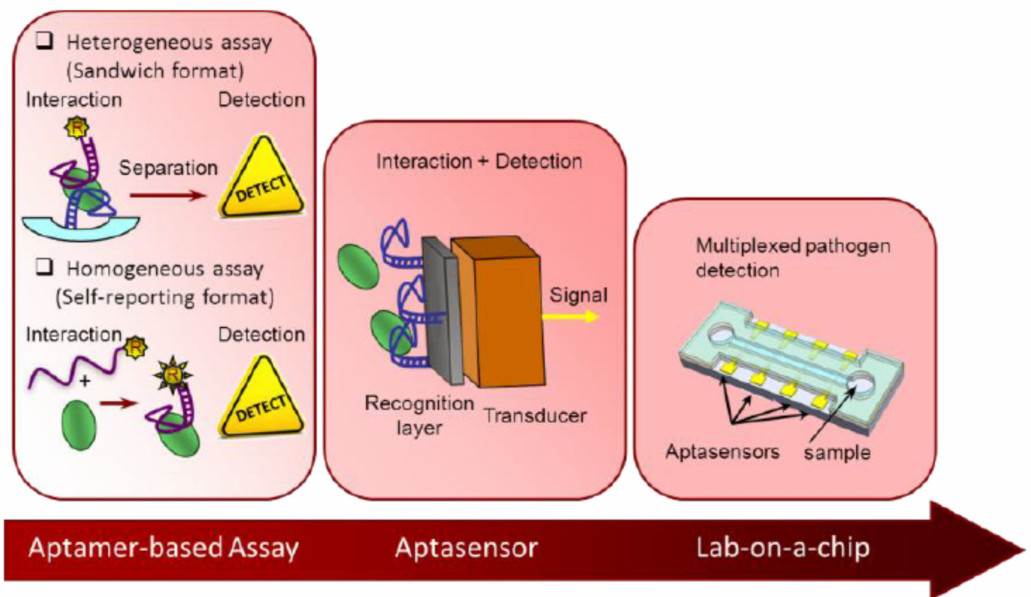
Figure 1. Aptamer-Based Analysis: A Promising Alternative for Food Safety Control. Reprinted from reference [12].